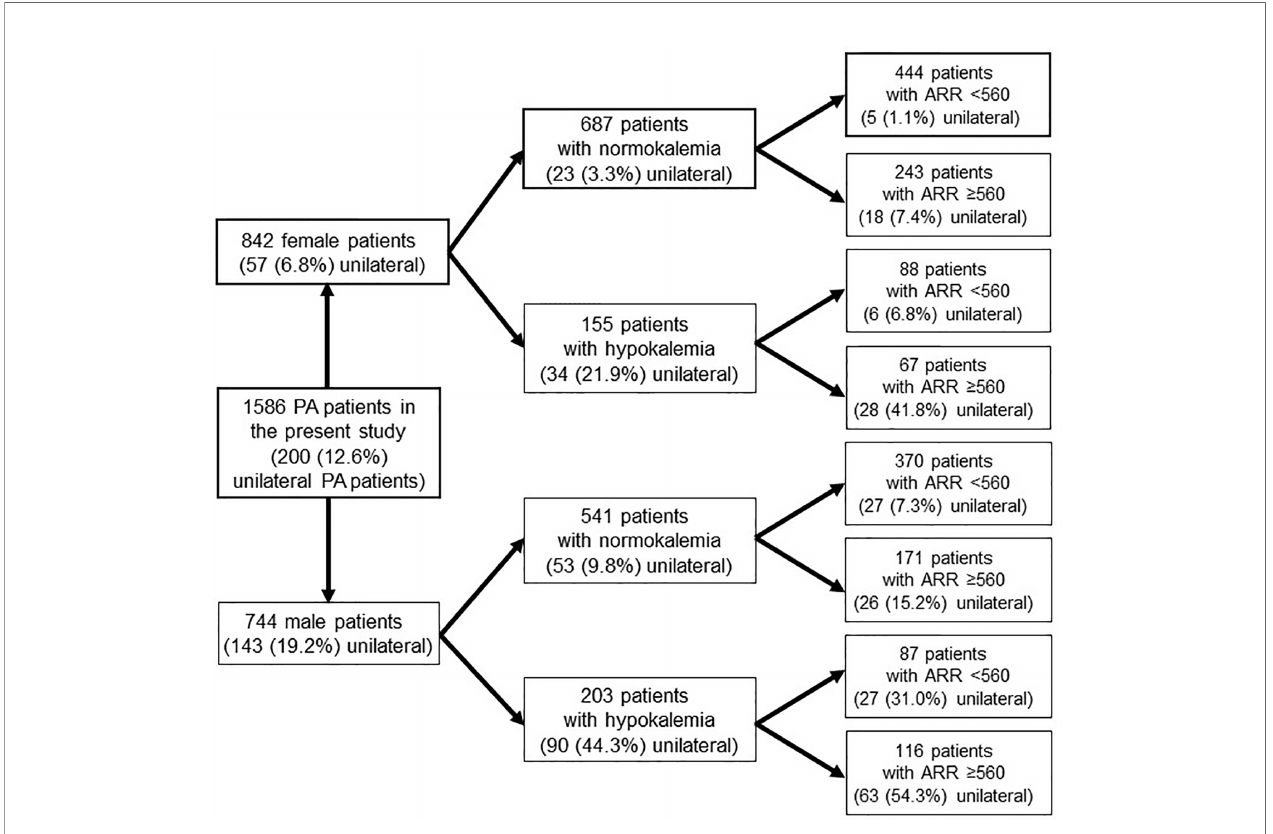
FIGURE 2 | The prevalence of PA patients in each